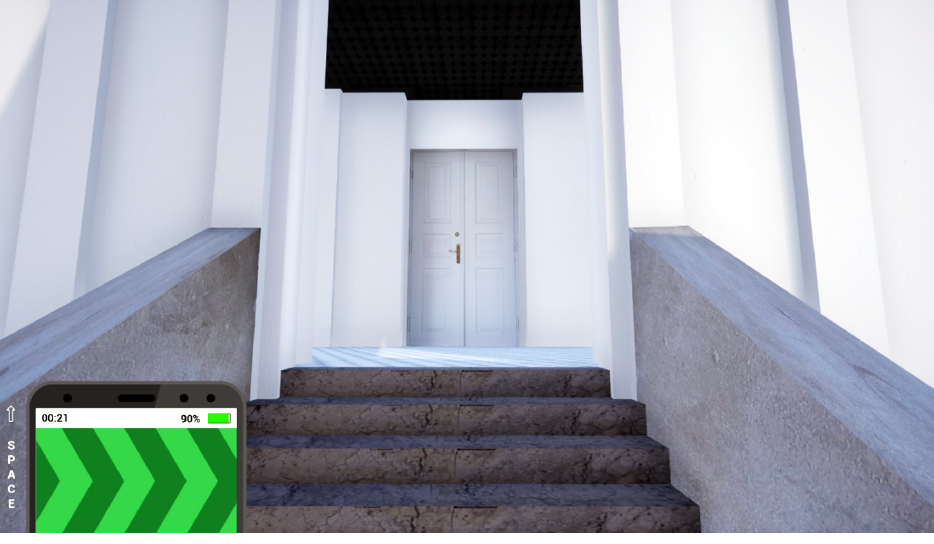
Fig. 8. Screenshot showing the appearance of the developed application The developed prototype application displayed pant had to be in the area which triggered the navigation messages when the player (partici- message (trigger box), for example, approach ing pant) fulfilled two conditions. First, the partici - a fork in the route. Second, the player had